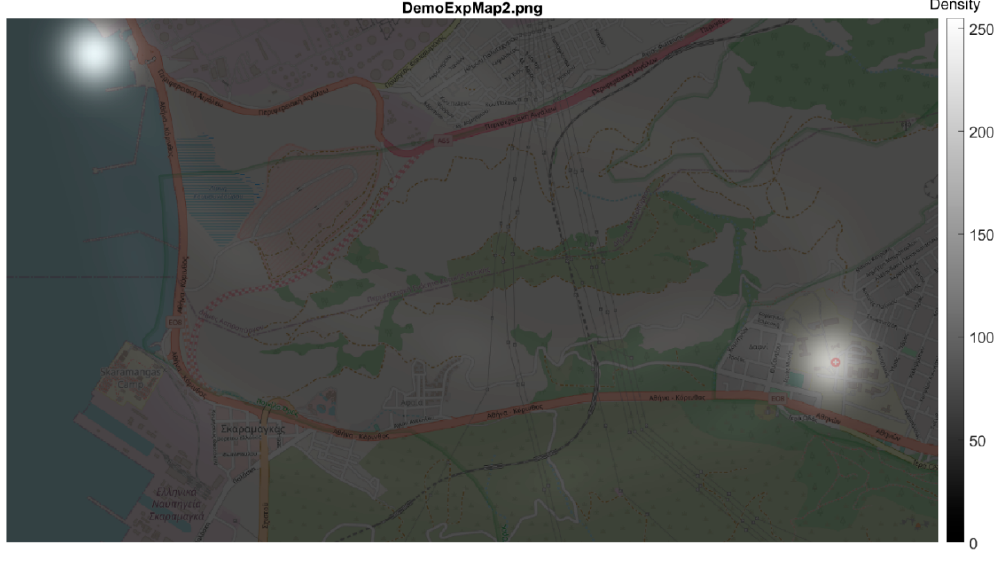
Figure 7. Heatmap visualization.